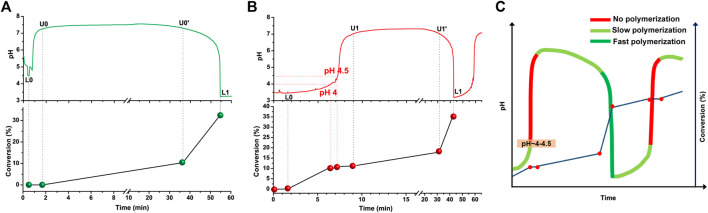
pH oscillations and corresponding monomer conversions in the first oscillatory period. The starting pH value (after the addition of PEG-CTA and HPMA) (A) 4.5 or (B) < 4 (lowered by the addition of H2SO4). The other conditions are the same as in Figure 1, except the T = 25°C (C) Periodic changes in the rate of polymerization in pH ranges of each period.